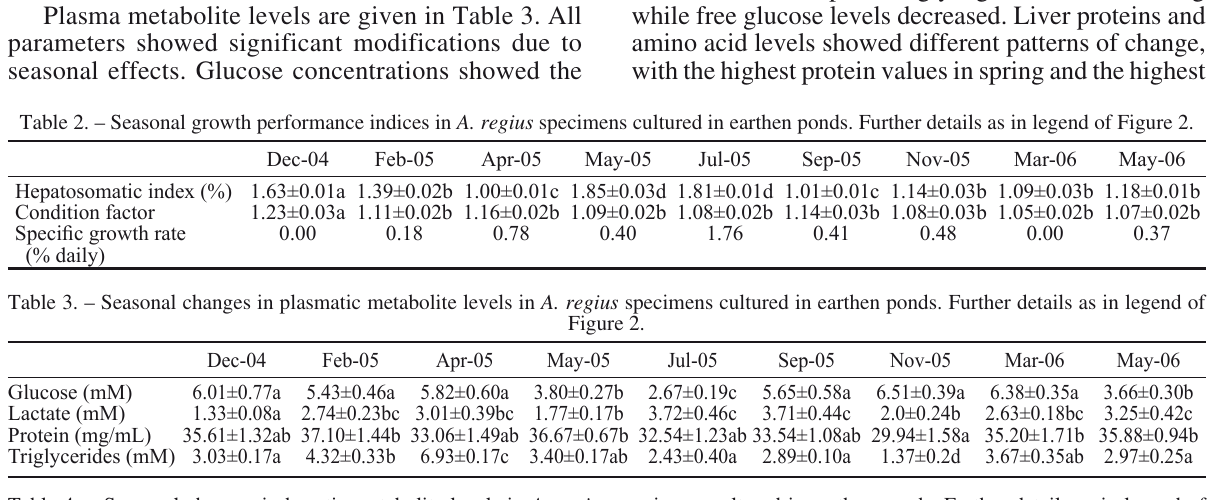
Table 4. – Seasonal changes in hepatic metabolite levels in A. regius specimens cultured in earthen ponds. Further details as in legend of Figure